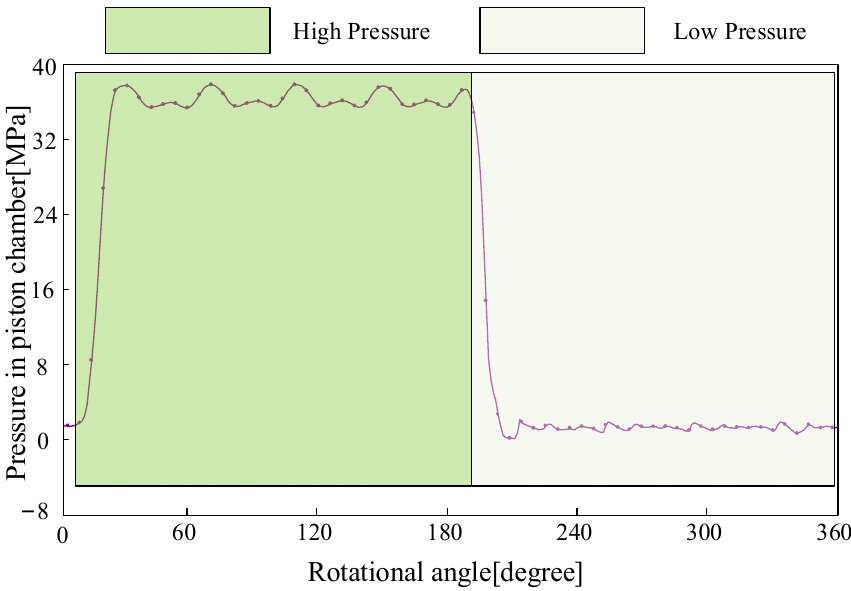
Figure 11. Pressure in piston chamber with constant outlet pressure pout (36 MPa) and constant shaft speed n (1500 r/min).